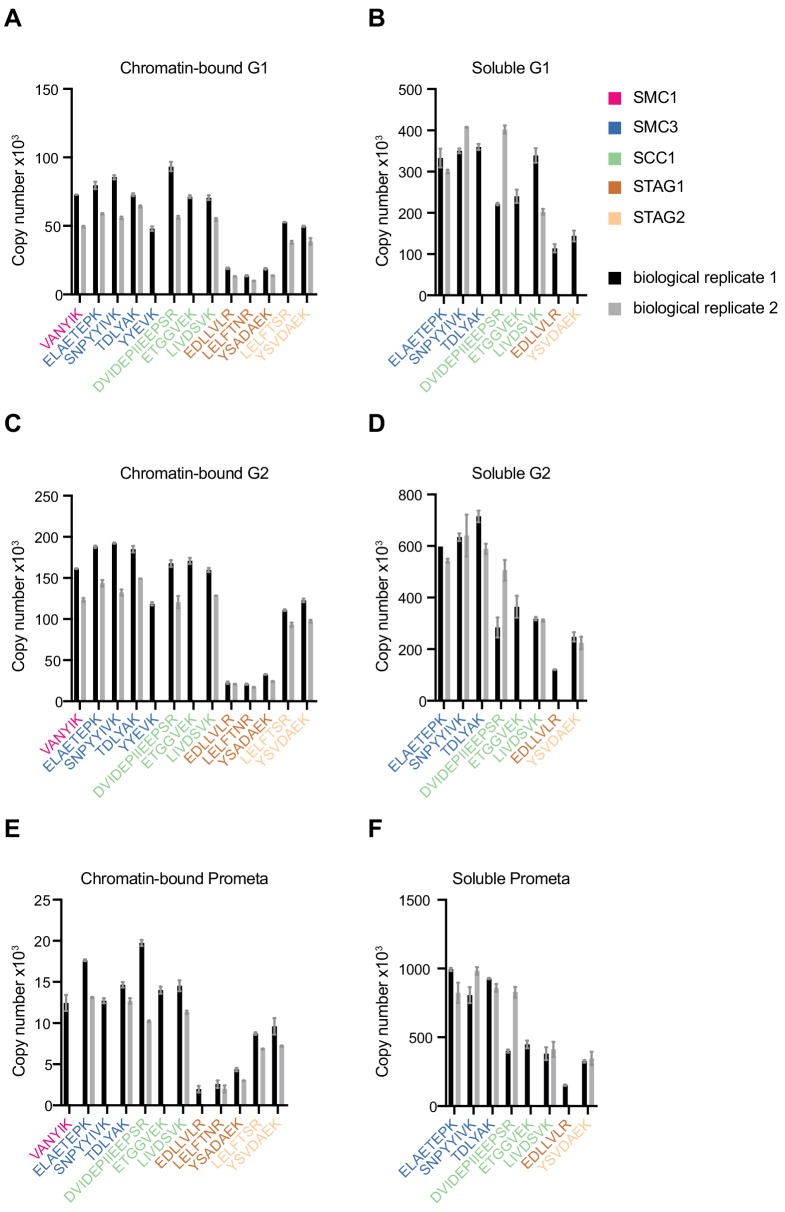
LC-MS quantification of cohesin subunit copy number.Absolute quantification of individual SMC1, SMC3, SCC1, STAG1 and STAG2 peptides used to generate the mean cohesin subunit copy numbers shown in Figure 1 and Table 1. Data are plotted as mean ± standard deviation of two technical replicates. A single technical replicate was quantified for peptide ELAETEPK in G2 soluble extract.